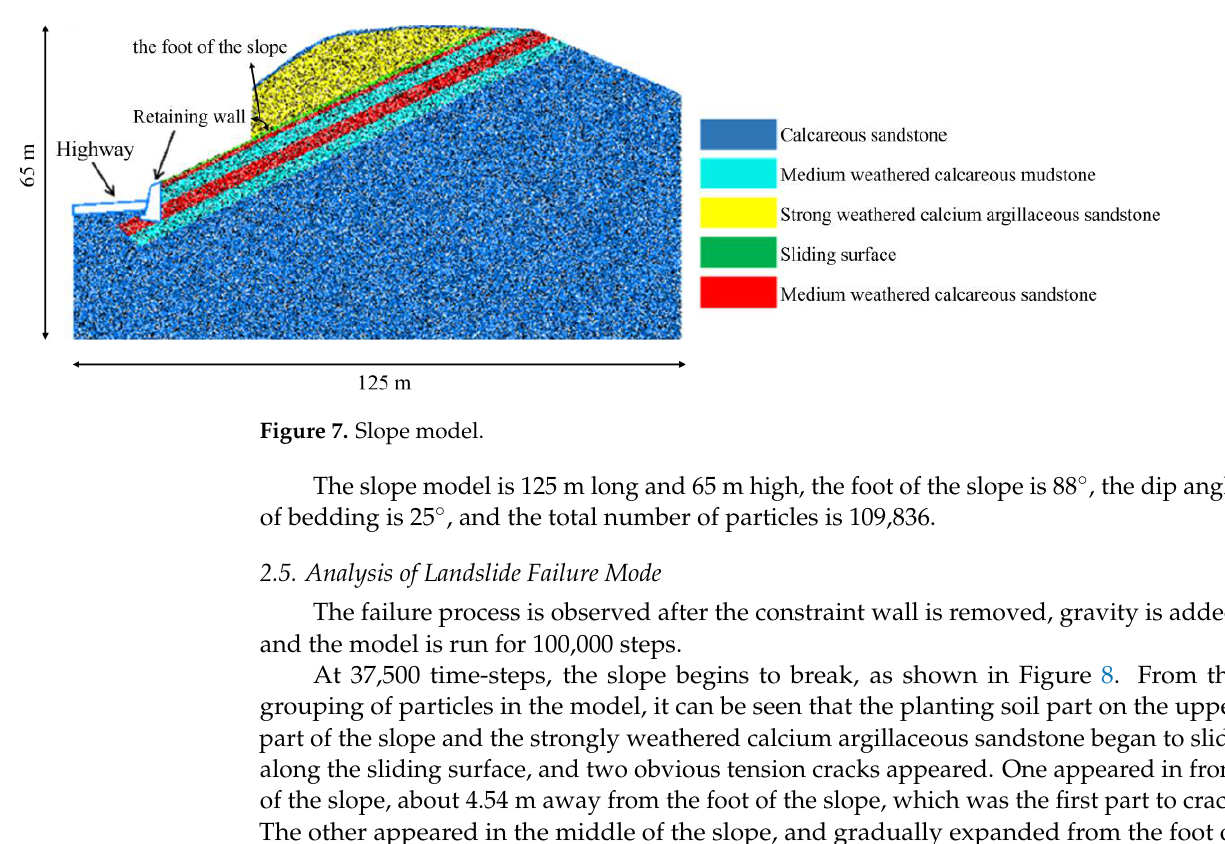
Figure 6. Schematic diagram of the Parallel-Bond Model.